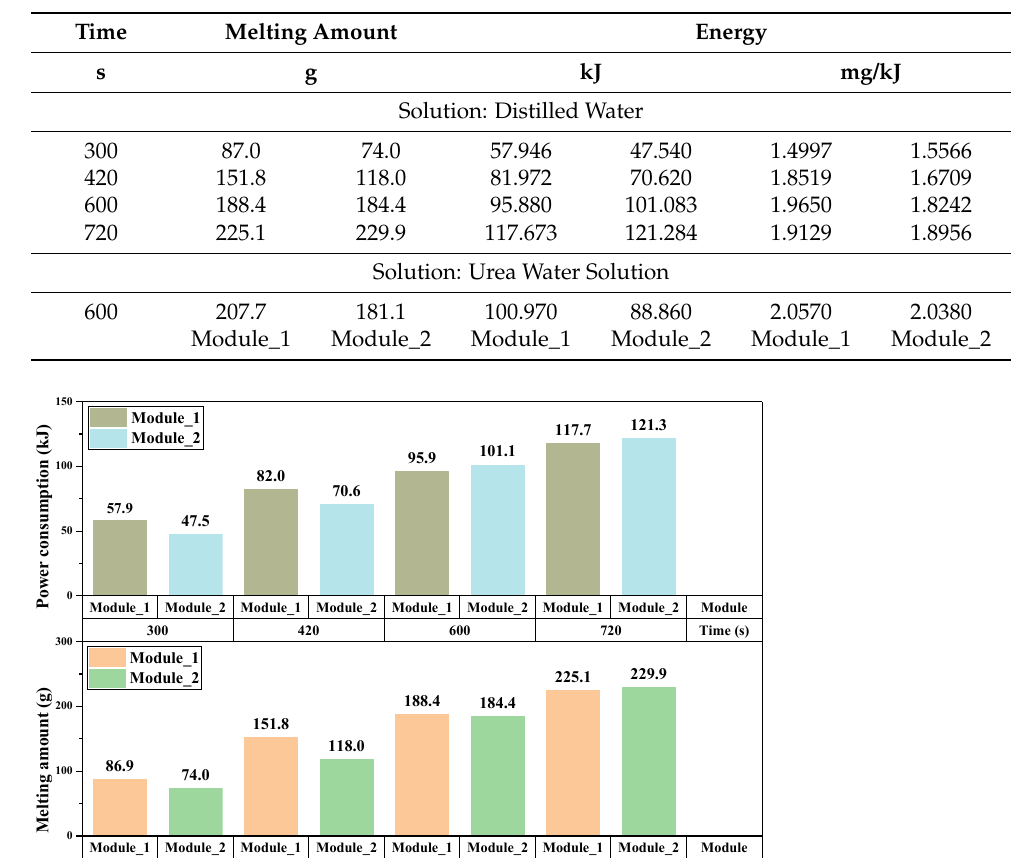
Table 3. Melting amount and energy consumption.